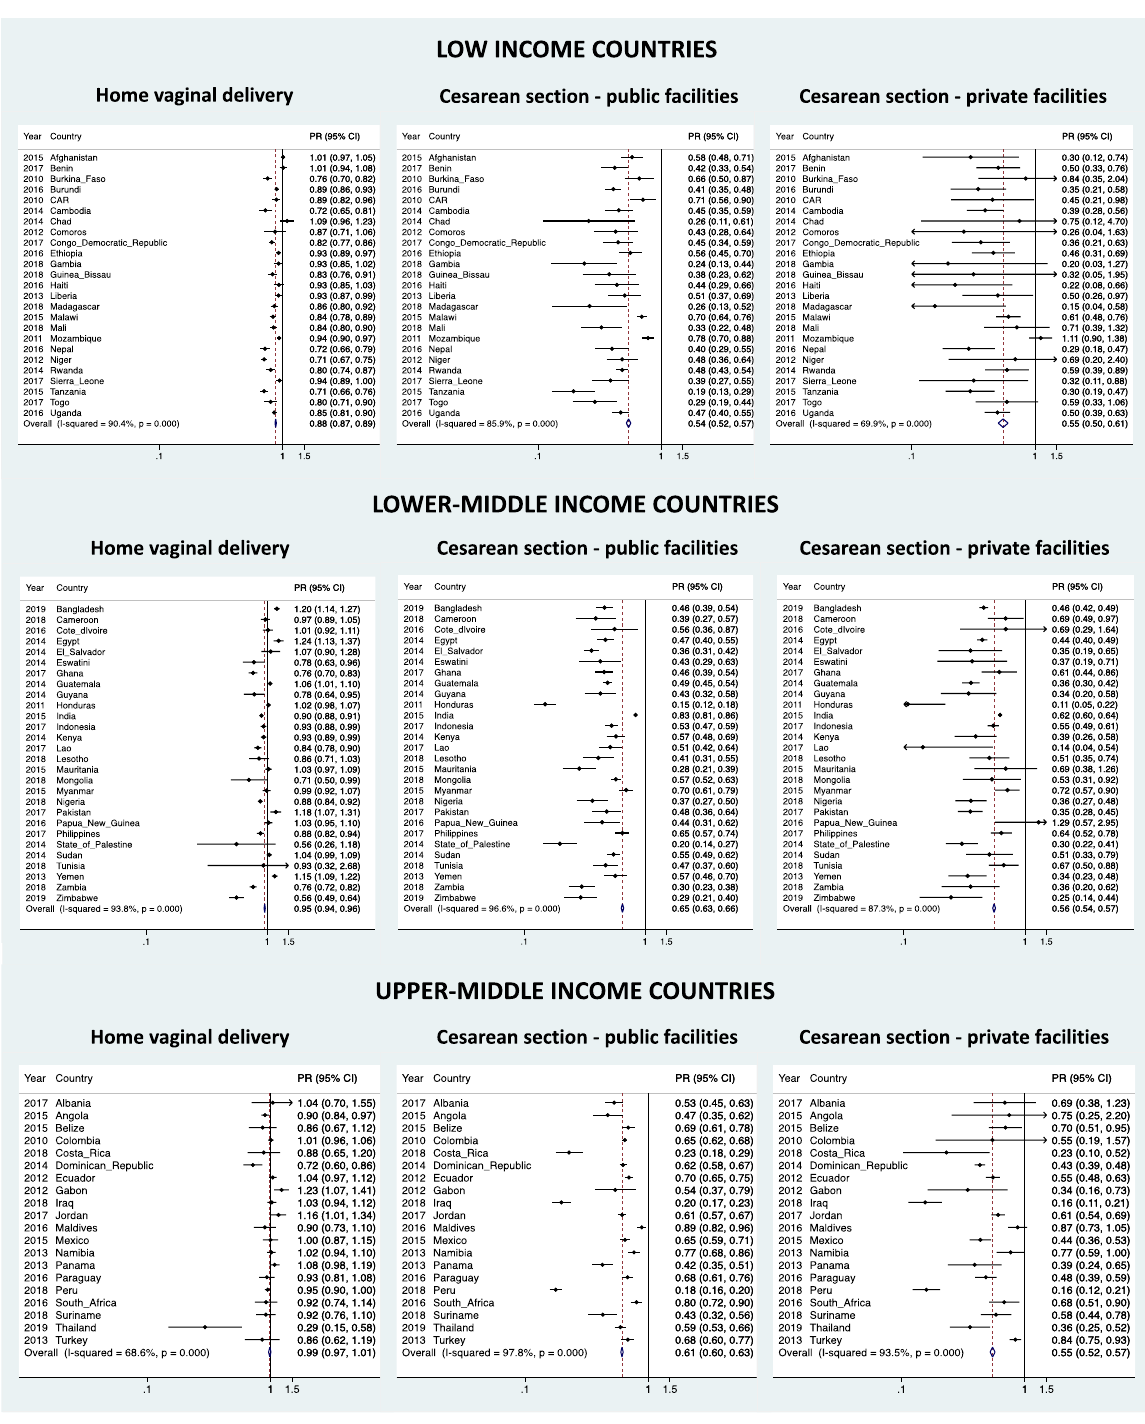
Figure 1. Prevalence ratio (PR) of early breastfeeding by type of delivery and place of birth of 73 countries by income country, taking institutional vaginal delivery as reference. Note Adjusted for living area, maternal education, maternal age, and wealth